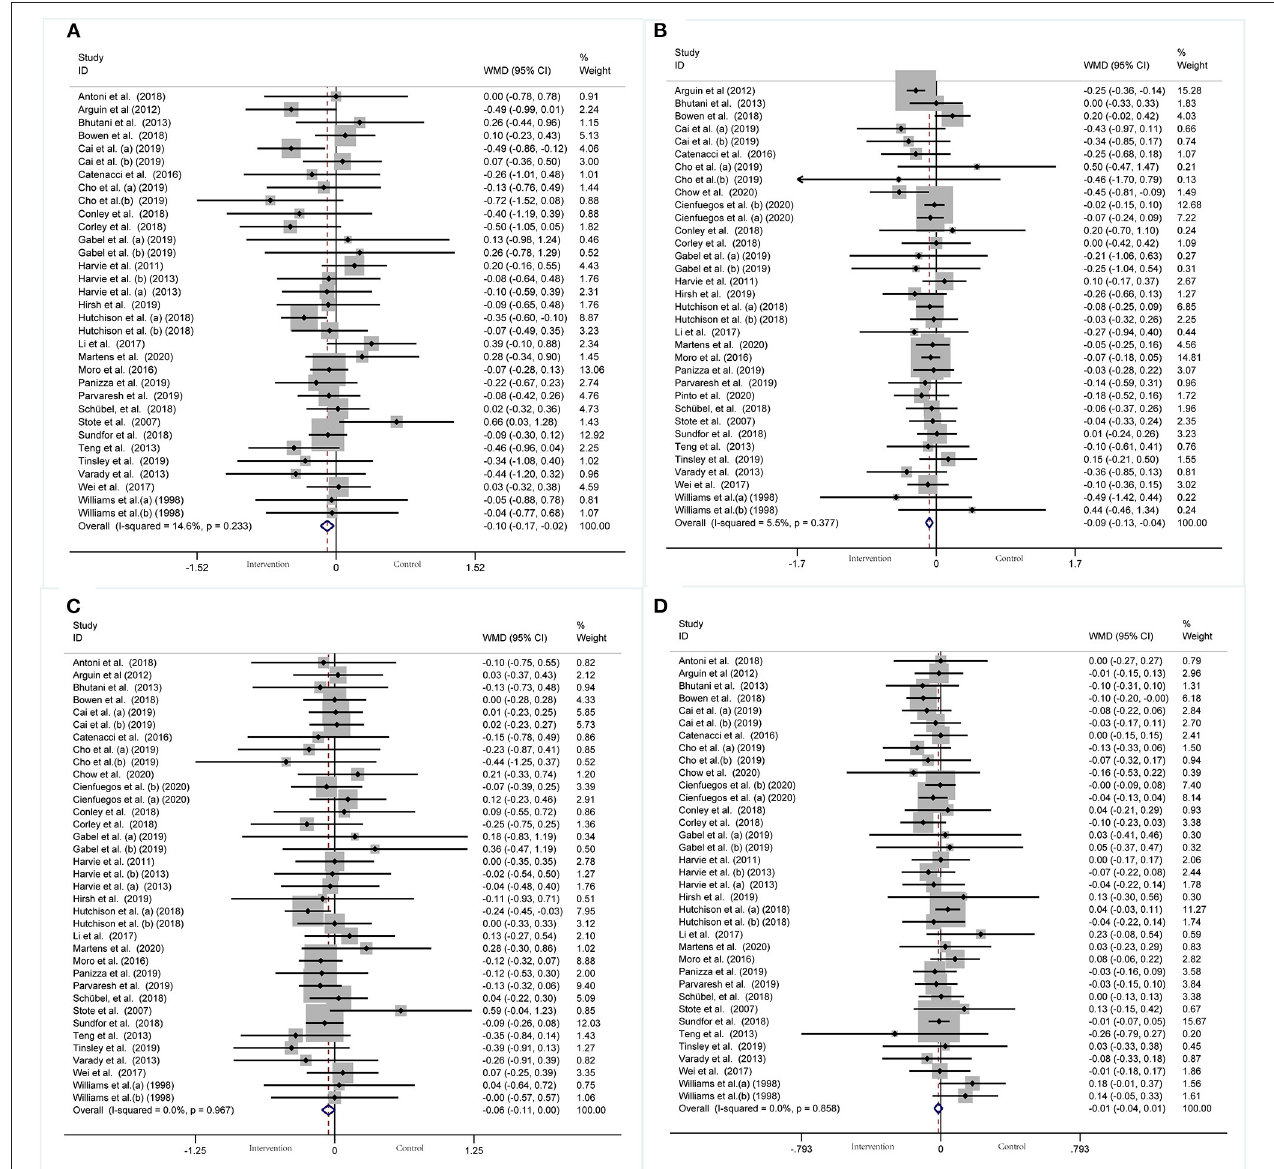
FIGURE 9 | Forest plot of RCTs investigating the effects of intermittent fasting on lipid panel (A) TC, (B) TG, (C) LDL-C, (D)